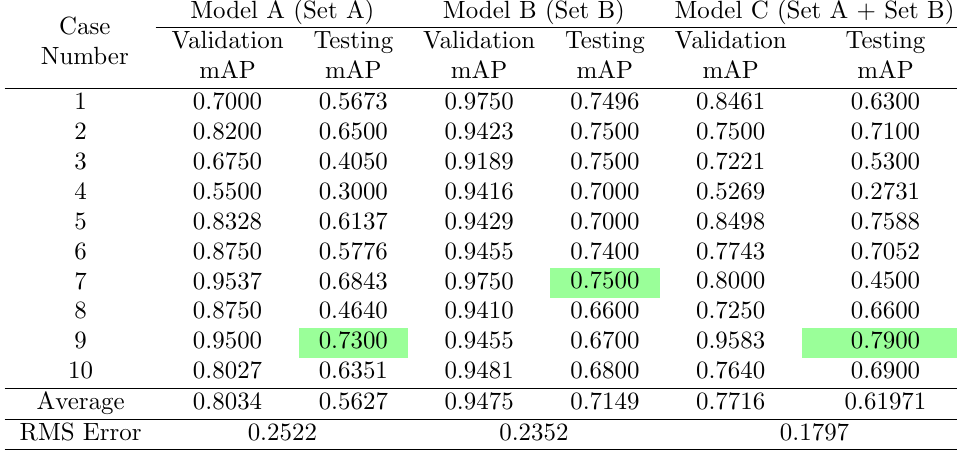
Table 3: Average precision obtained for different cases and models trained for Saithe. The range of values goes from 0 (for a precision of 0%) to 1 (for a precision of 100%)